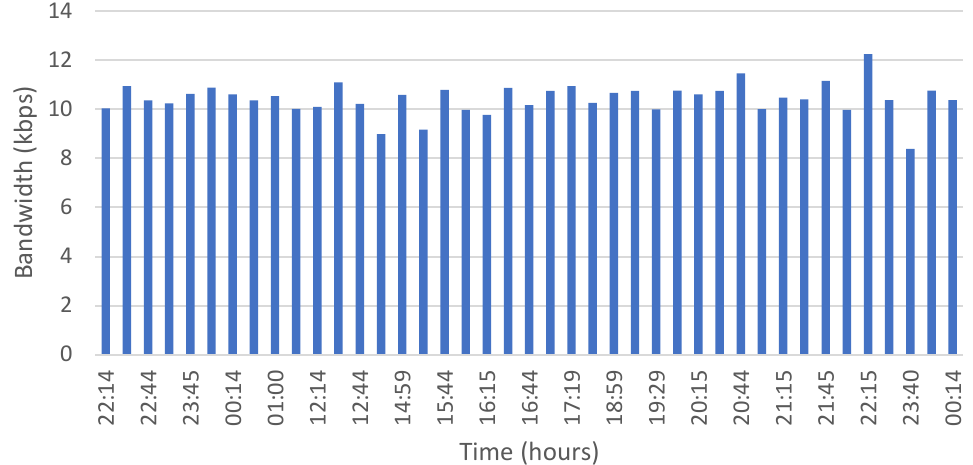
Figure 14. Bandwidth consumed uploading processed edge readings to an IoT dashboard (in the order of